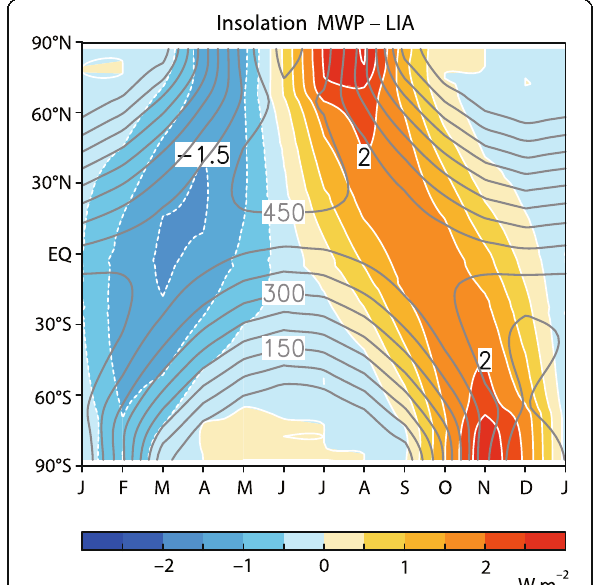
Fig. 1 Seasonal variation of insolation (W m − 2 ) at the top of the atmosphere averaged over 10 PMIP3 models. Shading represents the anomaly between the MWP (950 – 1250 A.D.) and LIA (1400 – 1800 A.D.; hereafter ML anomaly). Contours represent climatology in the